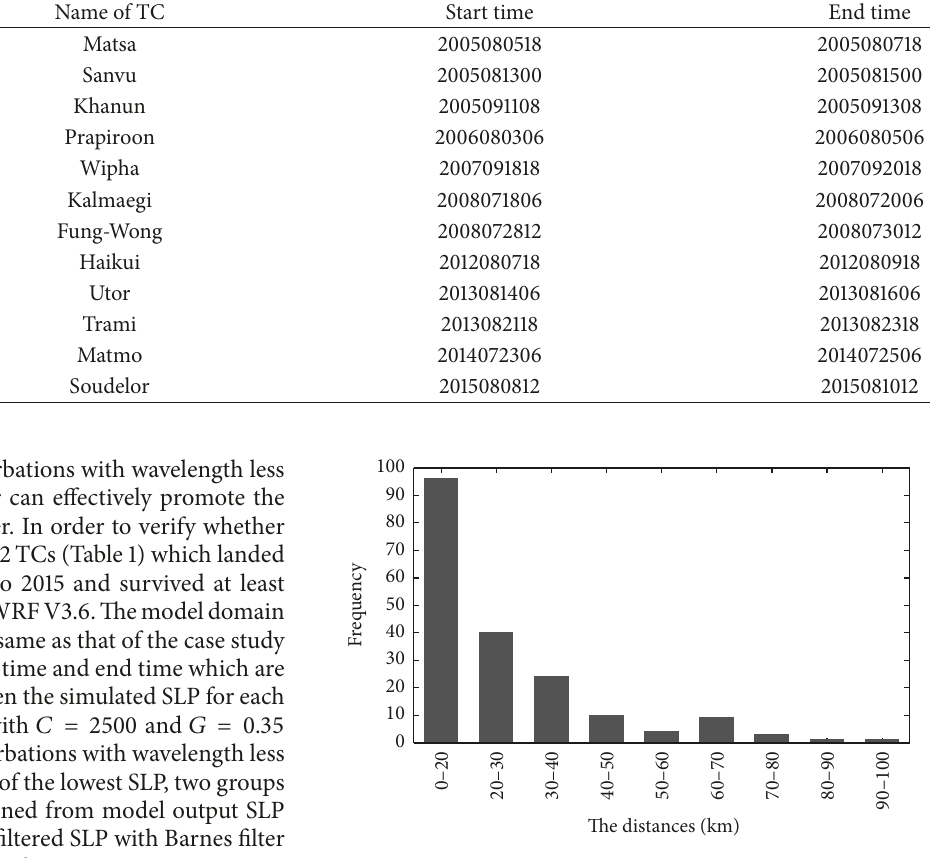
Figure 4: The histogram of distances between the TC centers ob- tained from SLP with and without Barnes